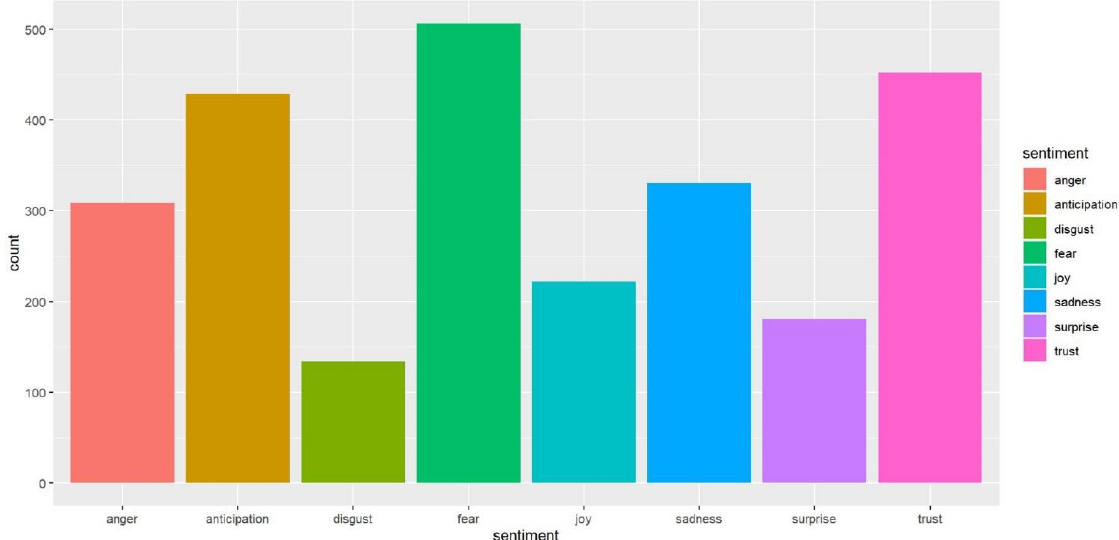
Figure 9. Number of words representing the sentiment dimensions (USA Today).